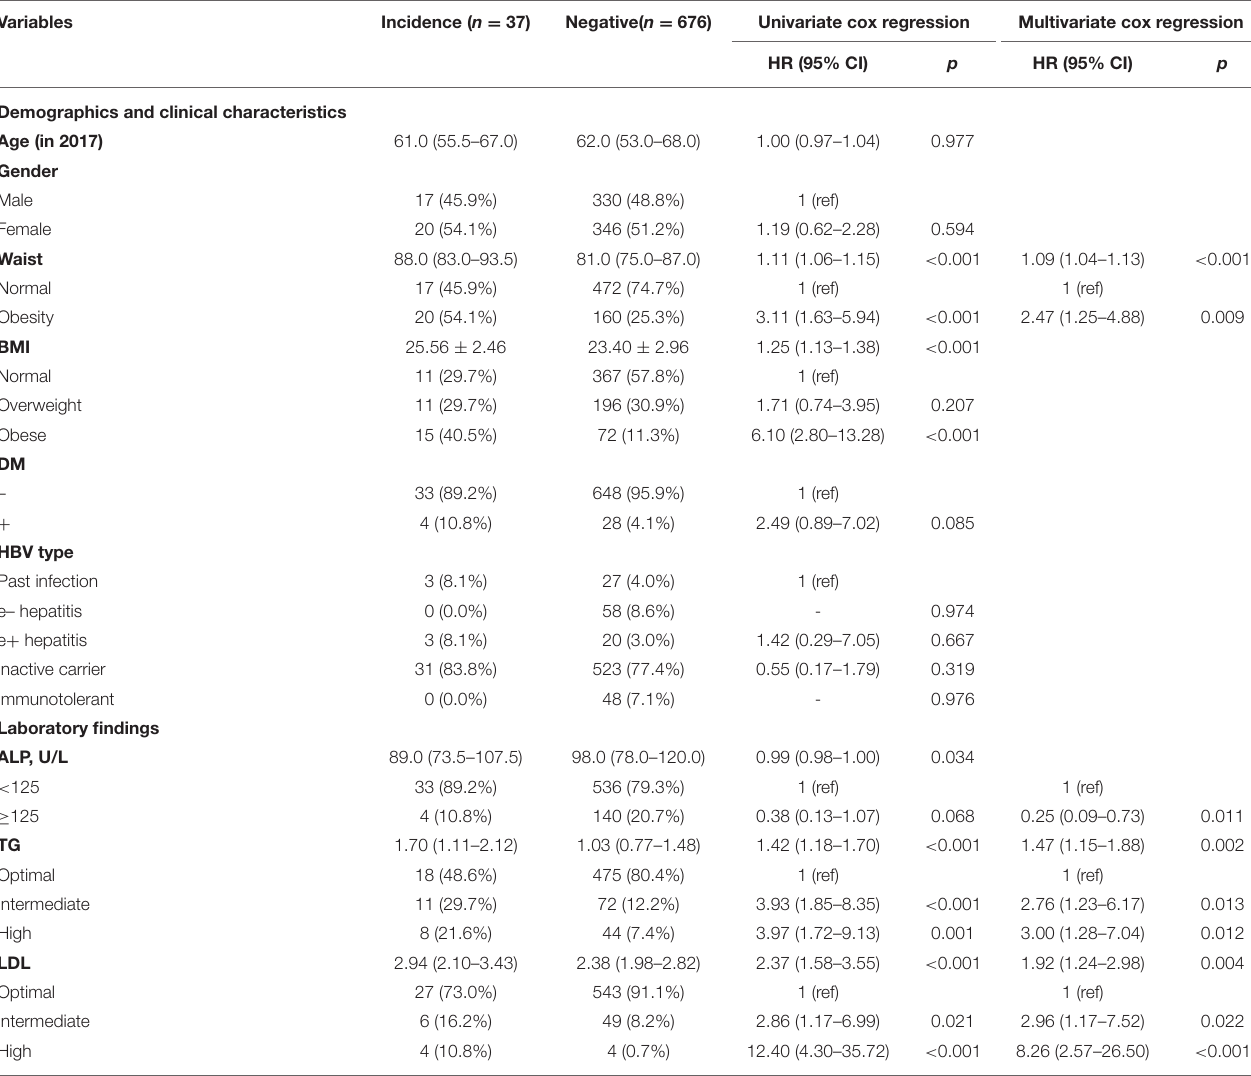
TABLE 3 | Risk factors associated with the incidence of